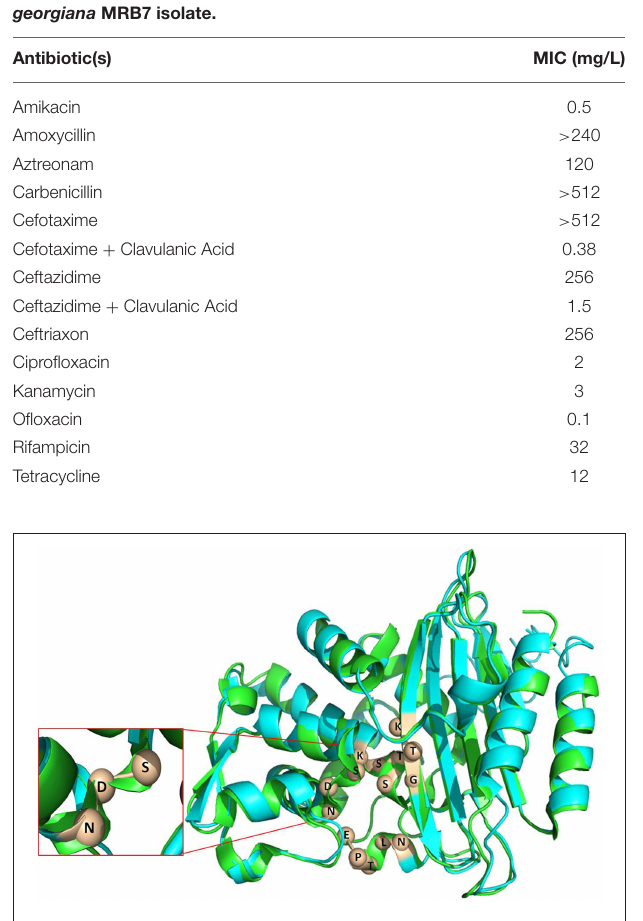
FIGURE 3 | Superimposed image of CTX-M-152(blue) and CTX-M-9 (green). The conserved element number 1 (S70-T71-S72-K73),